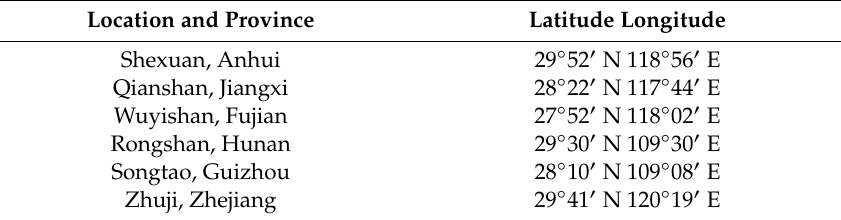
Table 1. The six regions with Chinese Torreya plantations in this